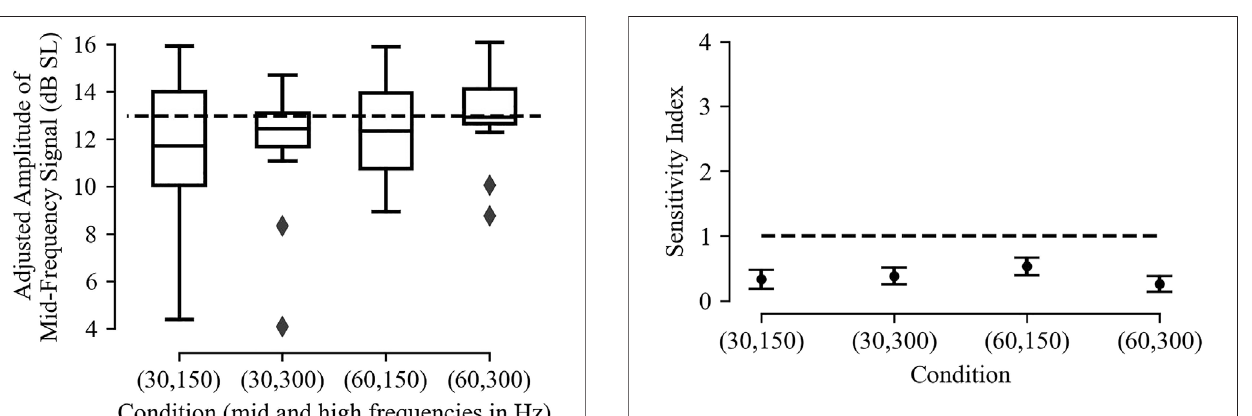
FIGURE 9 | Results of sensitivity index d ′ from pairwise discrimination in Exp. 3. The dashed horizontal line indicates d ′ = 1.0. Error bars denote ±1